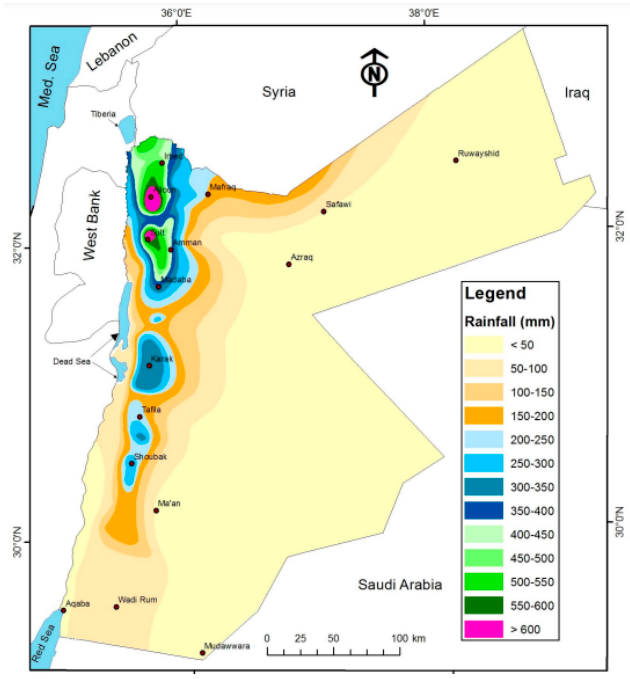
Figure 8. Rainfall distribution in Jordan [14].